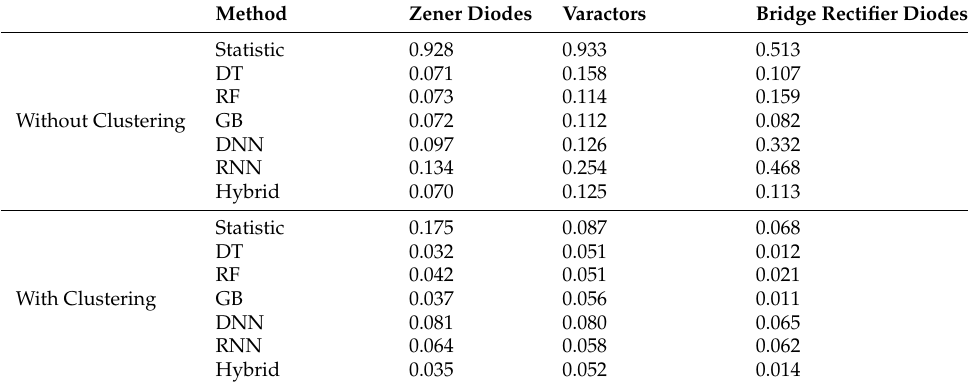
Table 9. MRE of the test data with and without